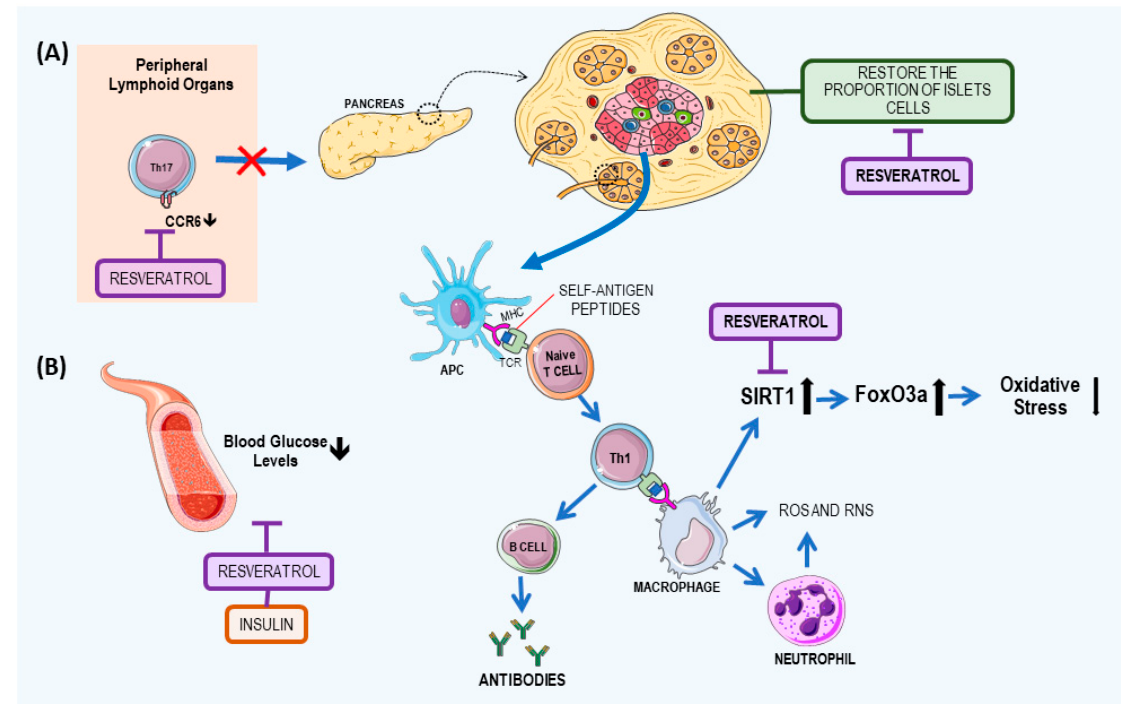
Figure 2. Type 1 diabetes mellitus disease mechanism and resveratrol role. Islet resident dendritic cell (DC) uptake of beta cell antigens, presenting to naïve T cells, and promoting T-helper 1